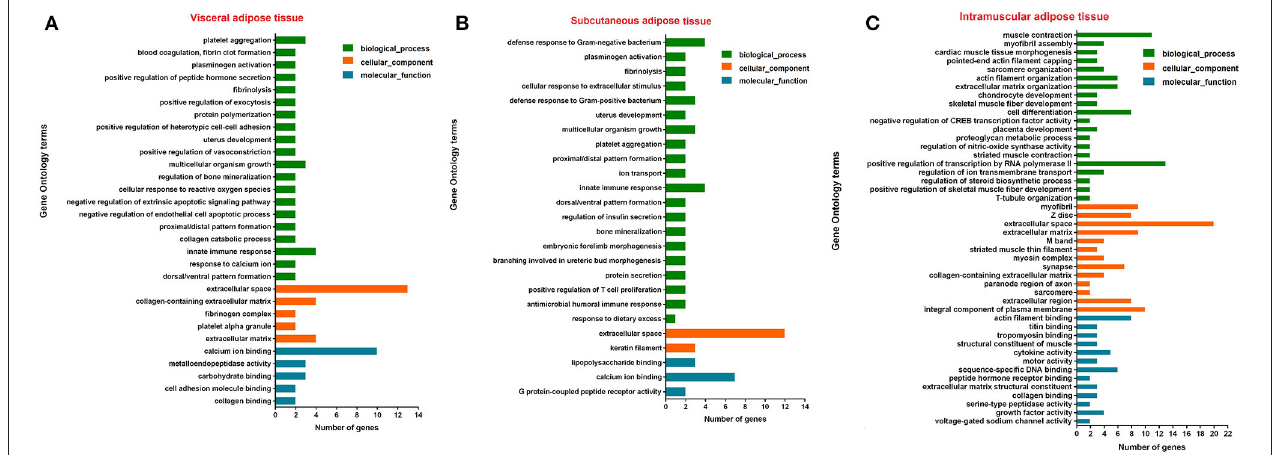
FIGURE 6 | Top 20 terms of GO analysis of visceral adipose (A) , subcutaneous adipose (B) , and intramuscular adipose (C) tissue-specific genes (corrected P <